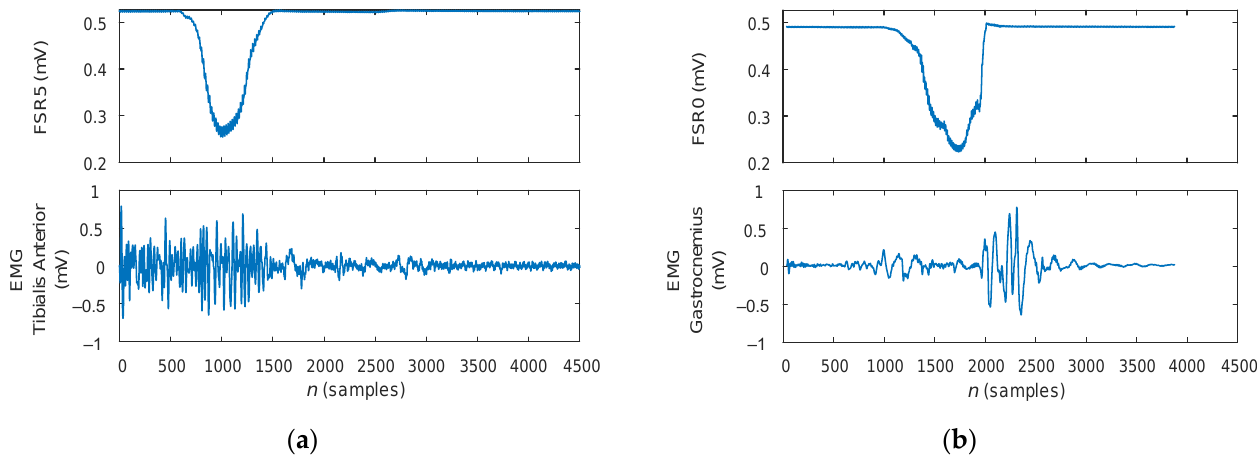
Figure 13. Time-domain plots of the force sensor resistors (FSR) and EMG signals illustrating a clear interdependency during the gait phases: ( a ) FSR 5 and tibialis anterior at heel strike, ( b ) FSR 0 and gastrocnemius at toe-off.